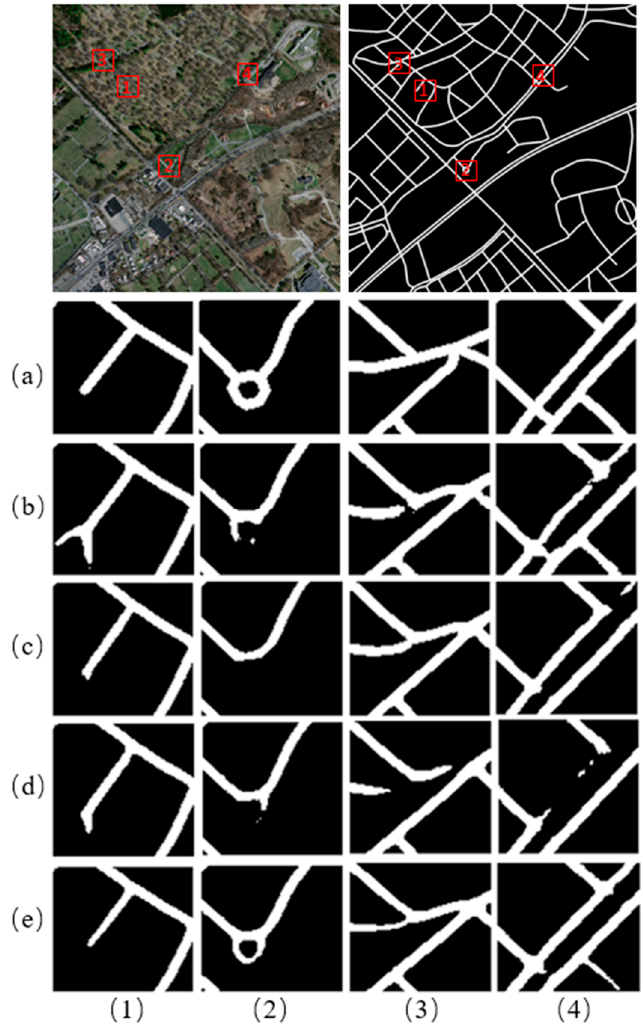
Figure 18. Four detailed areas of road extraction results in complicated scene images ( a ) area of label image; ( b ) D-LinkNet; ( c ) S-DenseNet; ( d ) SD-DenseNet;( e ) SDG-DenseNet.